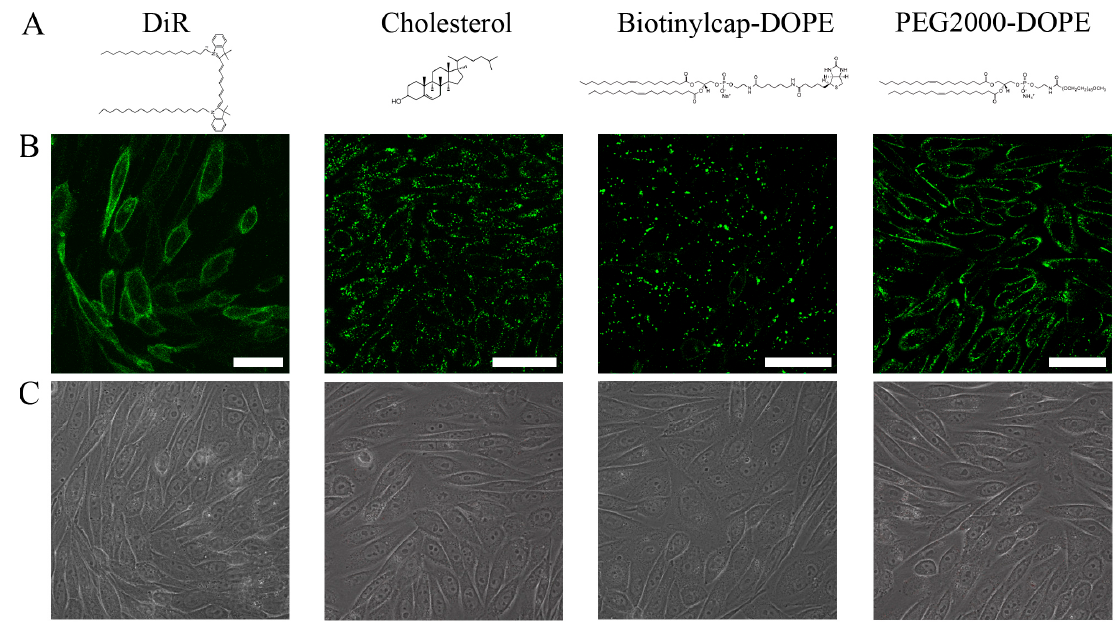
Figure 5. ( A ) Chemical structures of the aromatic DiR used as control, and the non-aromatic cholesterol, 1,2-dioleoyl-sn-glycero-3-phosphoethanolamine- N -(cap-biotinyl) (Biotinylcap-DOPE), and 1,2-dioleoyl-sn-glycero-3-phosphoethanolamine- N -[methoxy(polyethyleneglycol)-2000] (PEG2000-DOPE). ( B ) Fluorescence and ( C ) phase contrast images of CHO cells treated with liposomes containing the same components instead of an aromatic component, DOTAP as cationic lipid, DOPE as neutral lipid and BODIPY FL-DHPE as fluorescent tracer (0.1/1/1/0.02 mol/mol). BODIPY FL-DHPE was used at a non-fusogenic concentration. Scale bars, 50 µm.